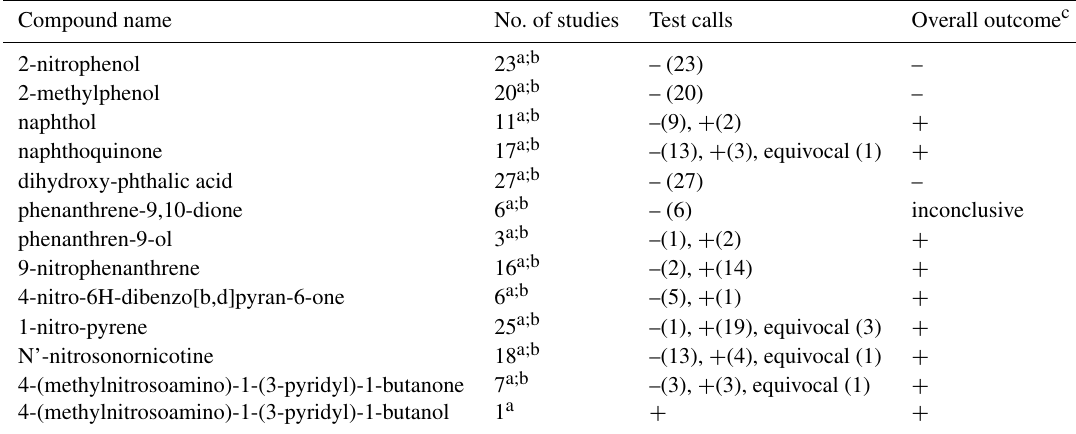
Table 1. Experimental data for Salmonella in vitro